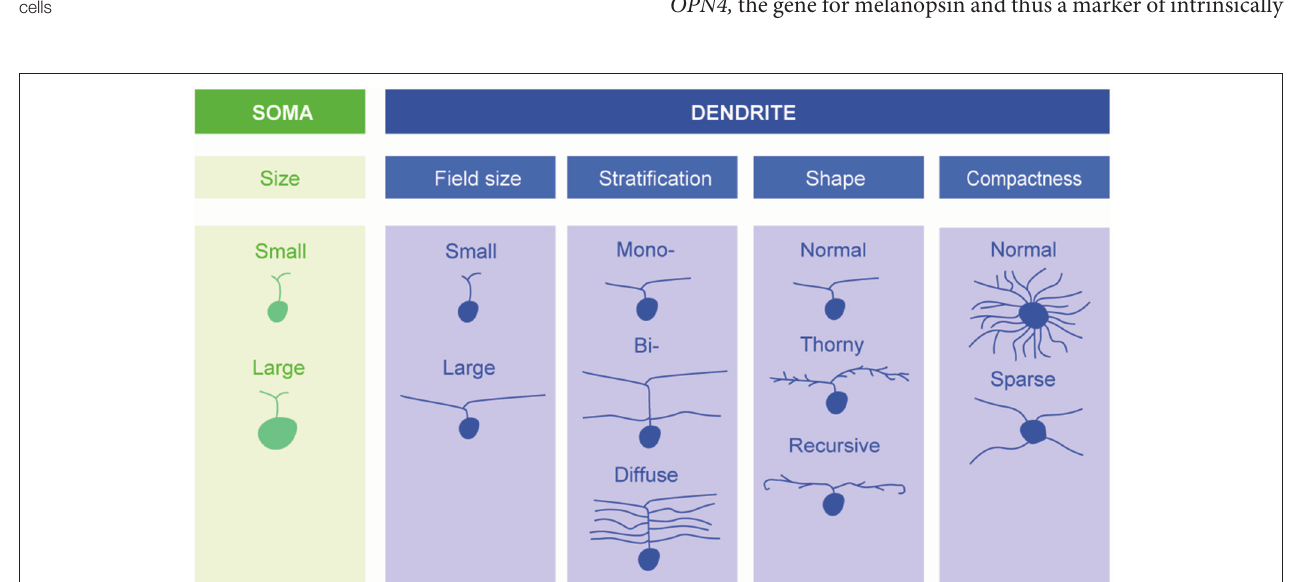
FIGURE 1 | Schematic description of retinal ganglion cells. Morphological types of RGCs are classified based on soma size and dendrite morphology ( by Ungsoo S. Kim ).